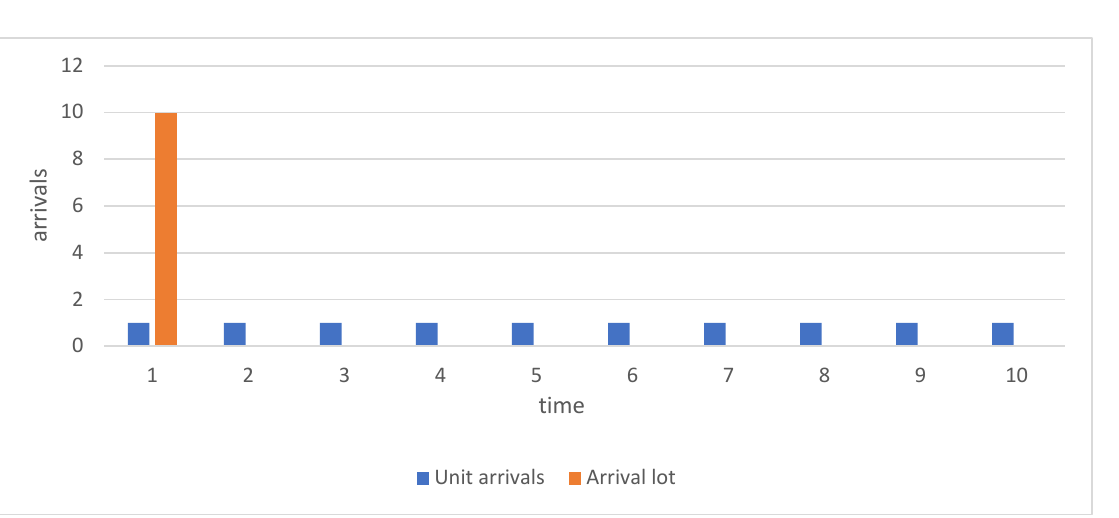
Figure 2. Difference between unit arrivals and batch arrivals.